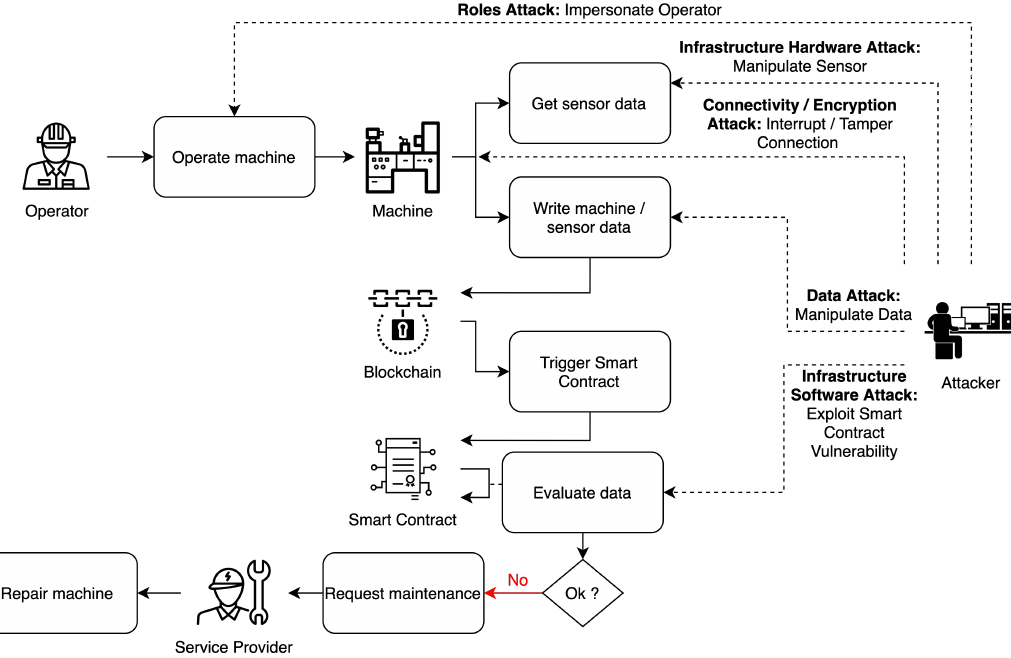
Figure 2. Diagram with attack possibilities (taken from the second column in Table